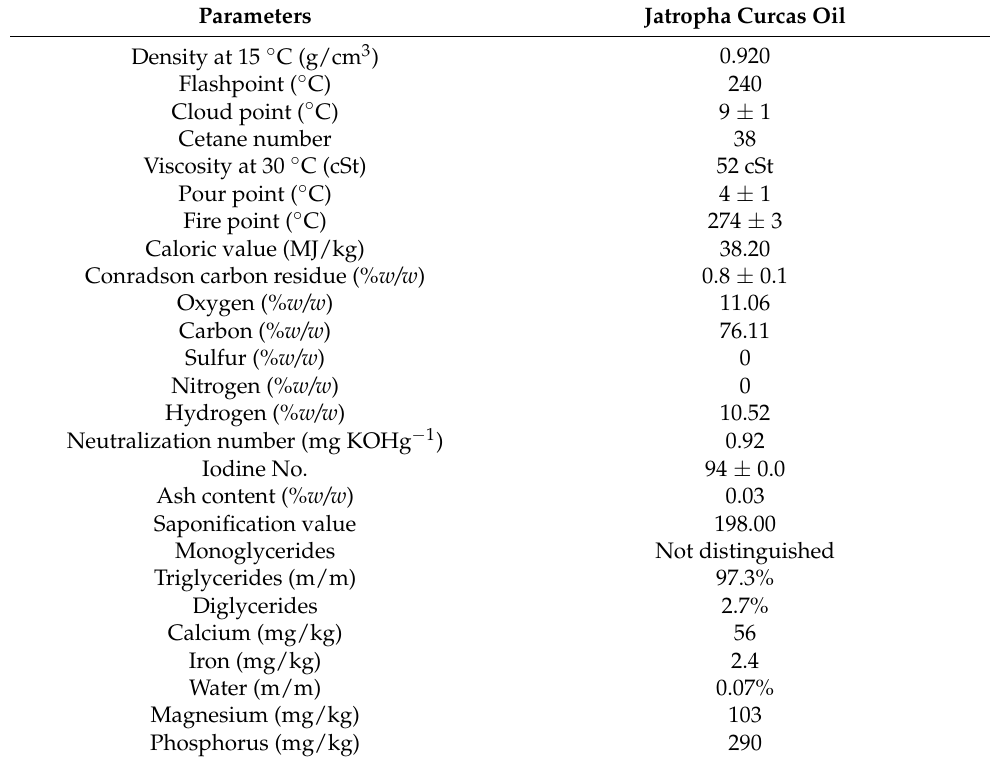
Table 3. Physicochemical characteristics of crude Jatropha Curcas oil [120,124,125].